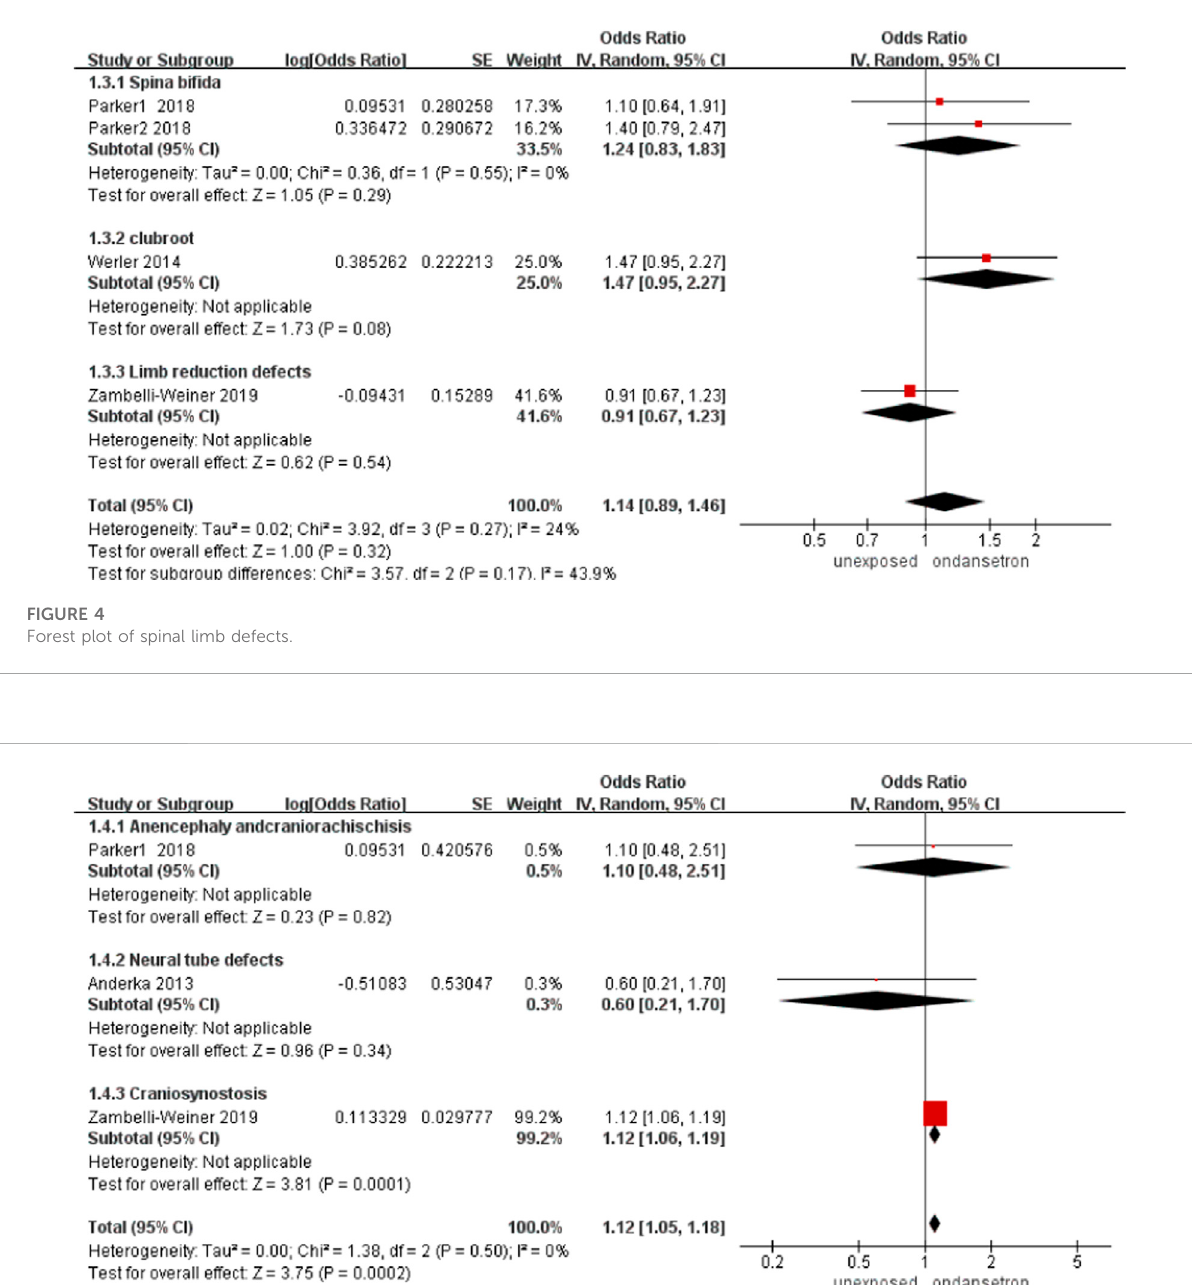
FIGURE 5 Forest plot of neural tube